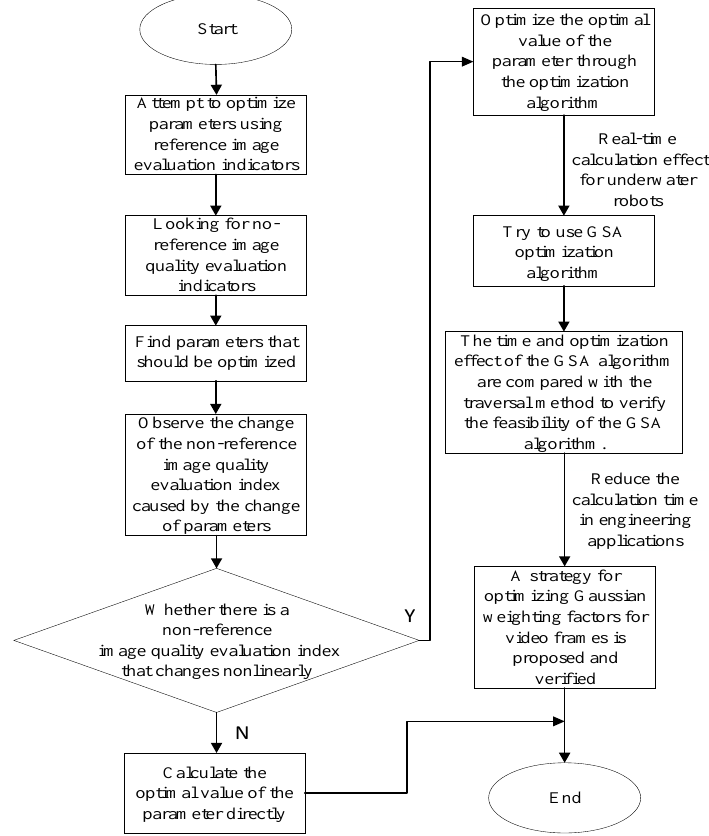
Figure 1. The working idea of this